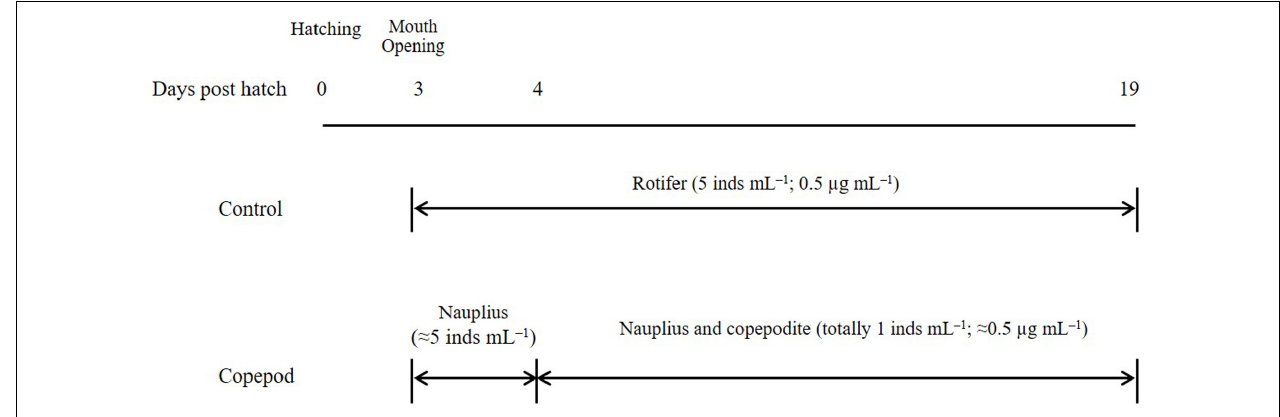
FIGURE 1 | Temporal change in prey items of larval red sea bream Pagrus major in experimental treatments (rotifers and copepods). Values in parentheses present densities based on individual number (ind. mL − 1 ) and dry mass ( µ g mL − 1 ). Rotifers were prepared by feeding docosahexaenoic acid-supplemented Super Fresh Chlorella (SFC); and the copepods fed algal mixture were used. Rotifer: Brachionus plicatilis sp. complex. Copepod: Pseudodiaptomus inopinus .